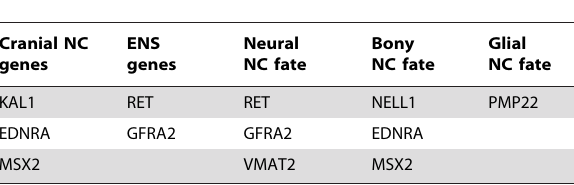
Table 4. Genetic determinants of diverse NC fates are induced by Gli1 in SY5Y